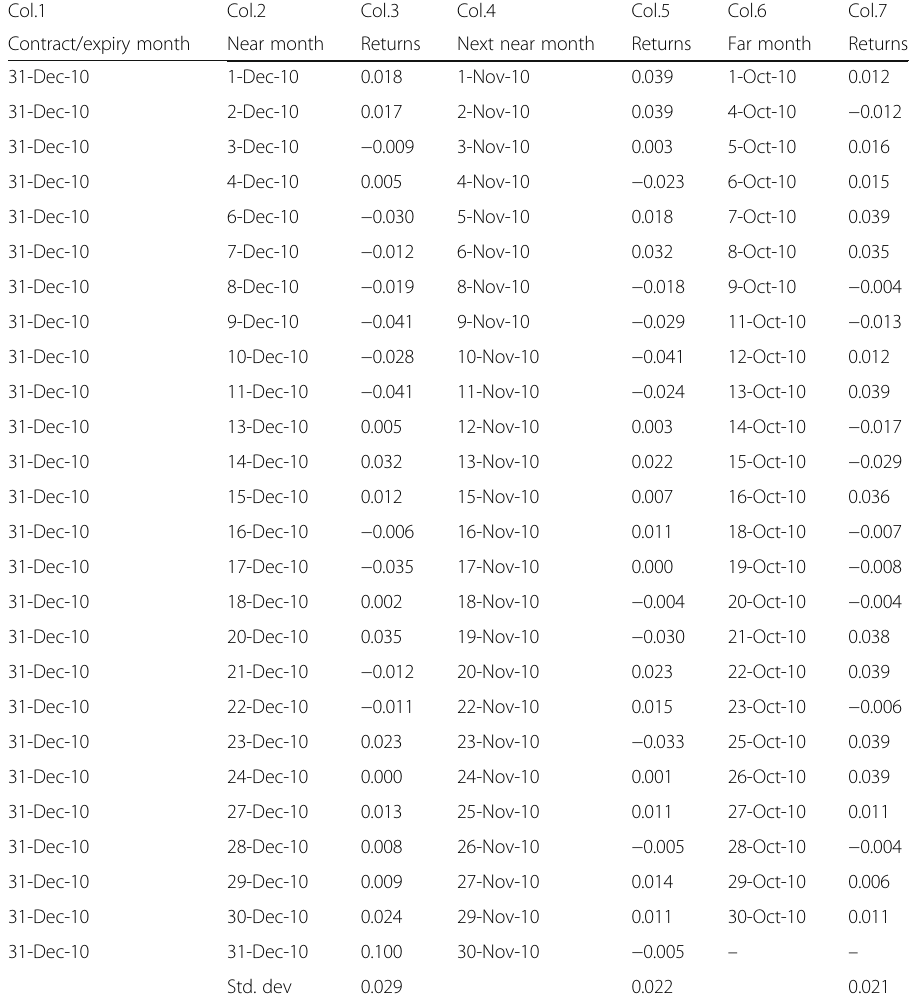
Table 2 Returns of near, next near and far month contracts of mentha oil maturing on